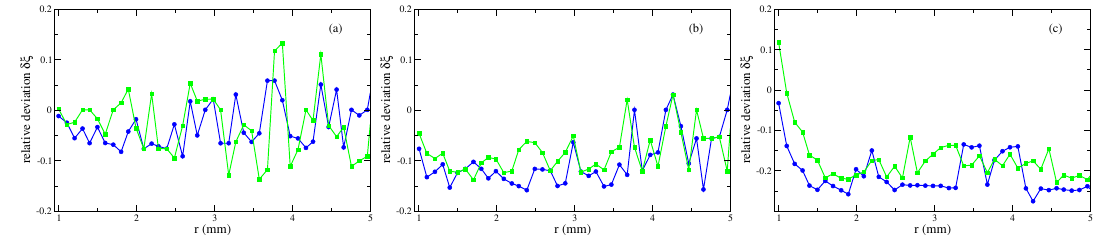
Figure 7. Relative deviation δξ , see Equation (8), of the numerically calculated menisci of the magnetic fluid EMG 909 using a nonlinear law of magnetisation ( • ) and a linear law with χ = 0.61 ( (cid:4) ). ( a ) H = 3.35 kA/m, ( b ) H = 7.54 kA/m and ( c ) H = 11.73 kA/m at R = 0.95 mm. The lines are guides for the eye. Note the different scales at the axes of